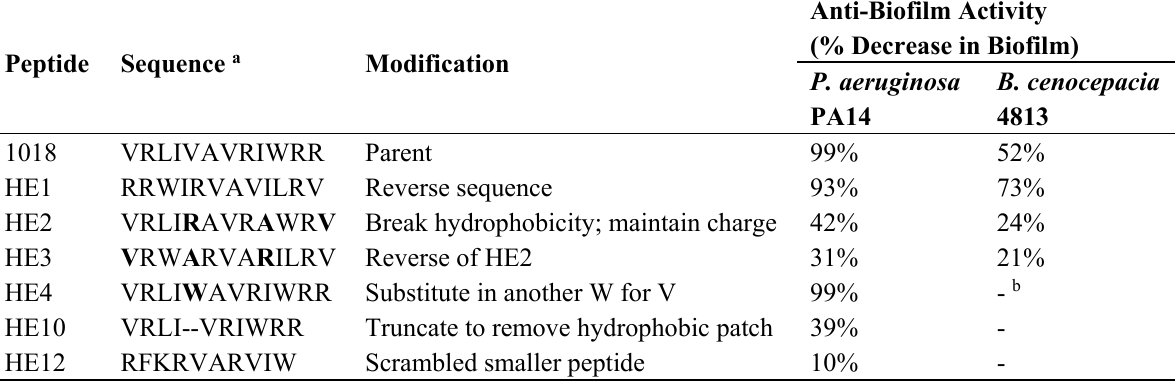
Table 4. Anti-biofilm activity of peptides derived from parent peptide 1018. In bold are shown the different amino acid substitutions made to parent peptide 1018. Hyphens indicate amino acid residues that were deleted in relation to peptide 1018. For peptides 1018, HE4, HE10, and HE12 the concentration used was 10 µg/mL. These studies were performed with a Bioflux apparatus resulting in the higher activity vs. Pseudomonas . For peptides HE1, HE2, and HE3, 15 µg/mL of peptide was used since 10 µg/mL of peptide showed low activity. The concentration of peptide used in each case was lower than the MIC for both P. aeruginosa (e.g., MICs for HE-4 and HE-12 vs . PA14 were 80 µg/mL) and B. cenocepacia (MICs > 256 µg/mL).